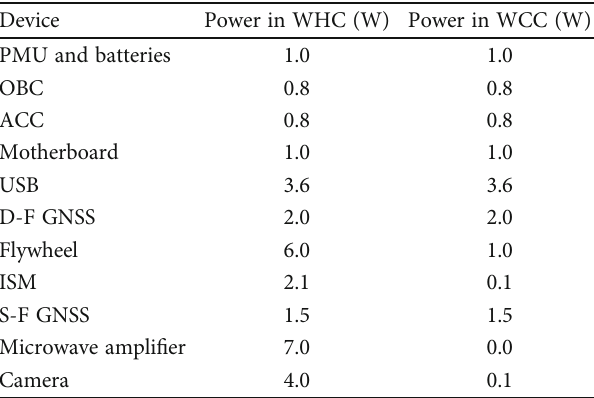
Table 3: The powers of devices in WHC and